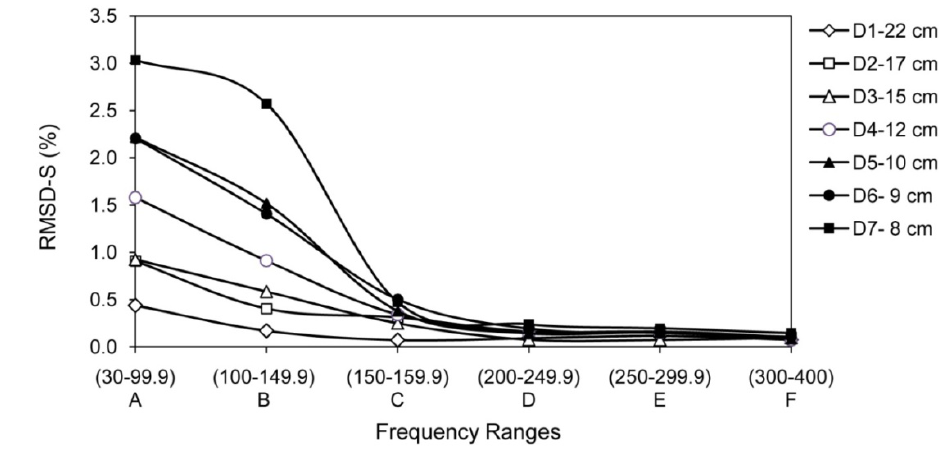
Figure 11. RMSD-S of damage D1 to D7 for PZT 4.